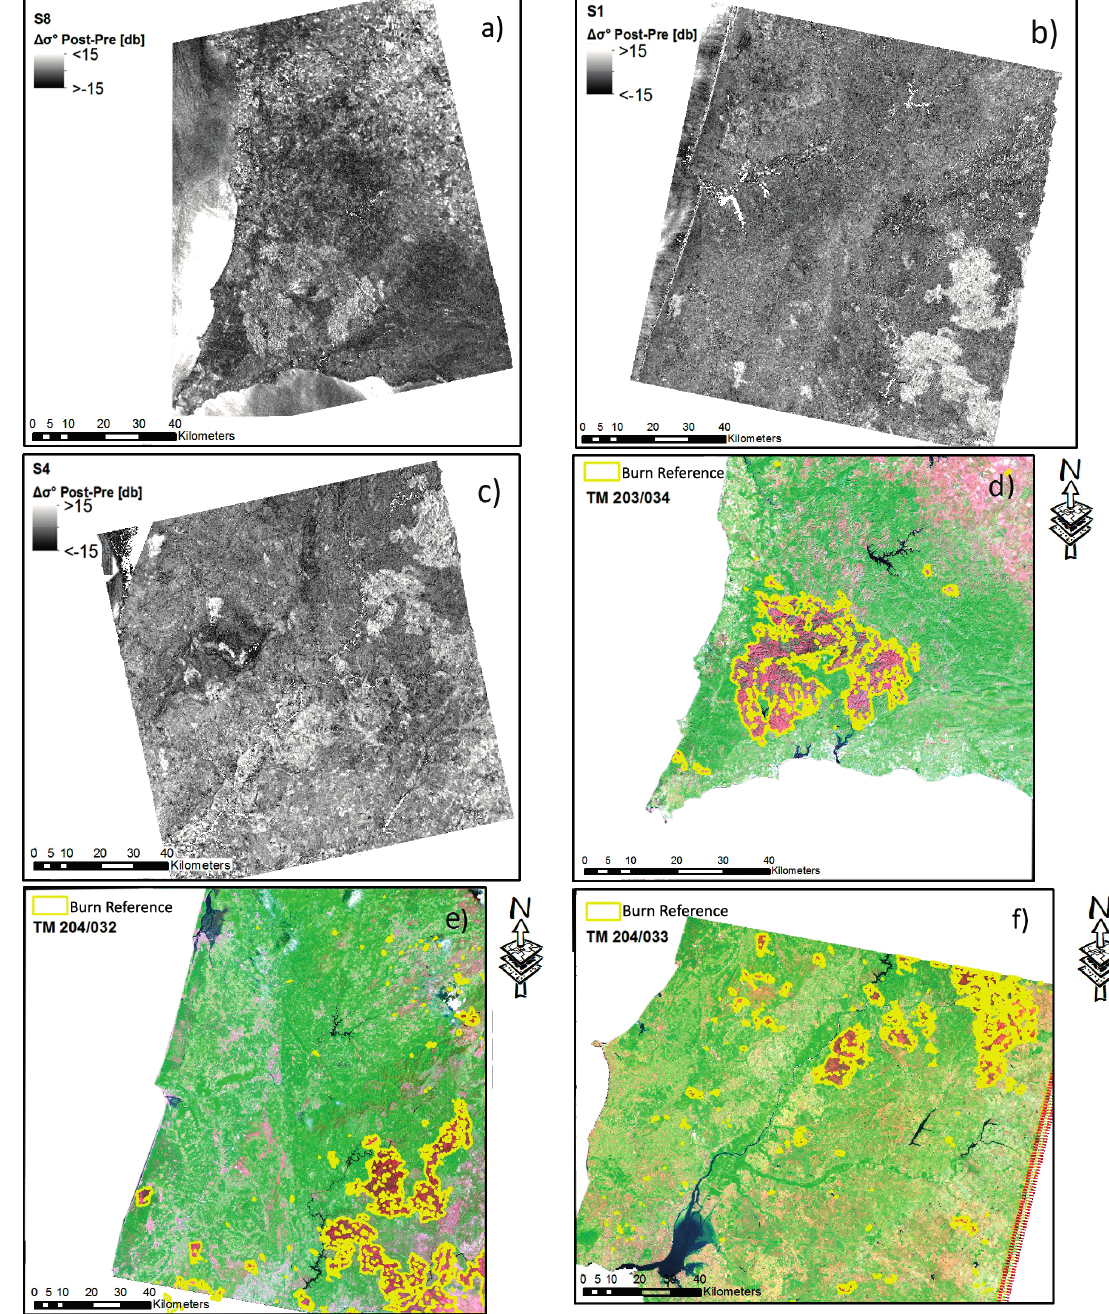
Figure 2. ( a , b , c ) Over sites s8, s1 and s4 the ∆σ ° maps and ( d , e , f ) the post-fire Landsat-5 TM false color composite (R-G-B 5-4-3)